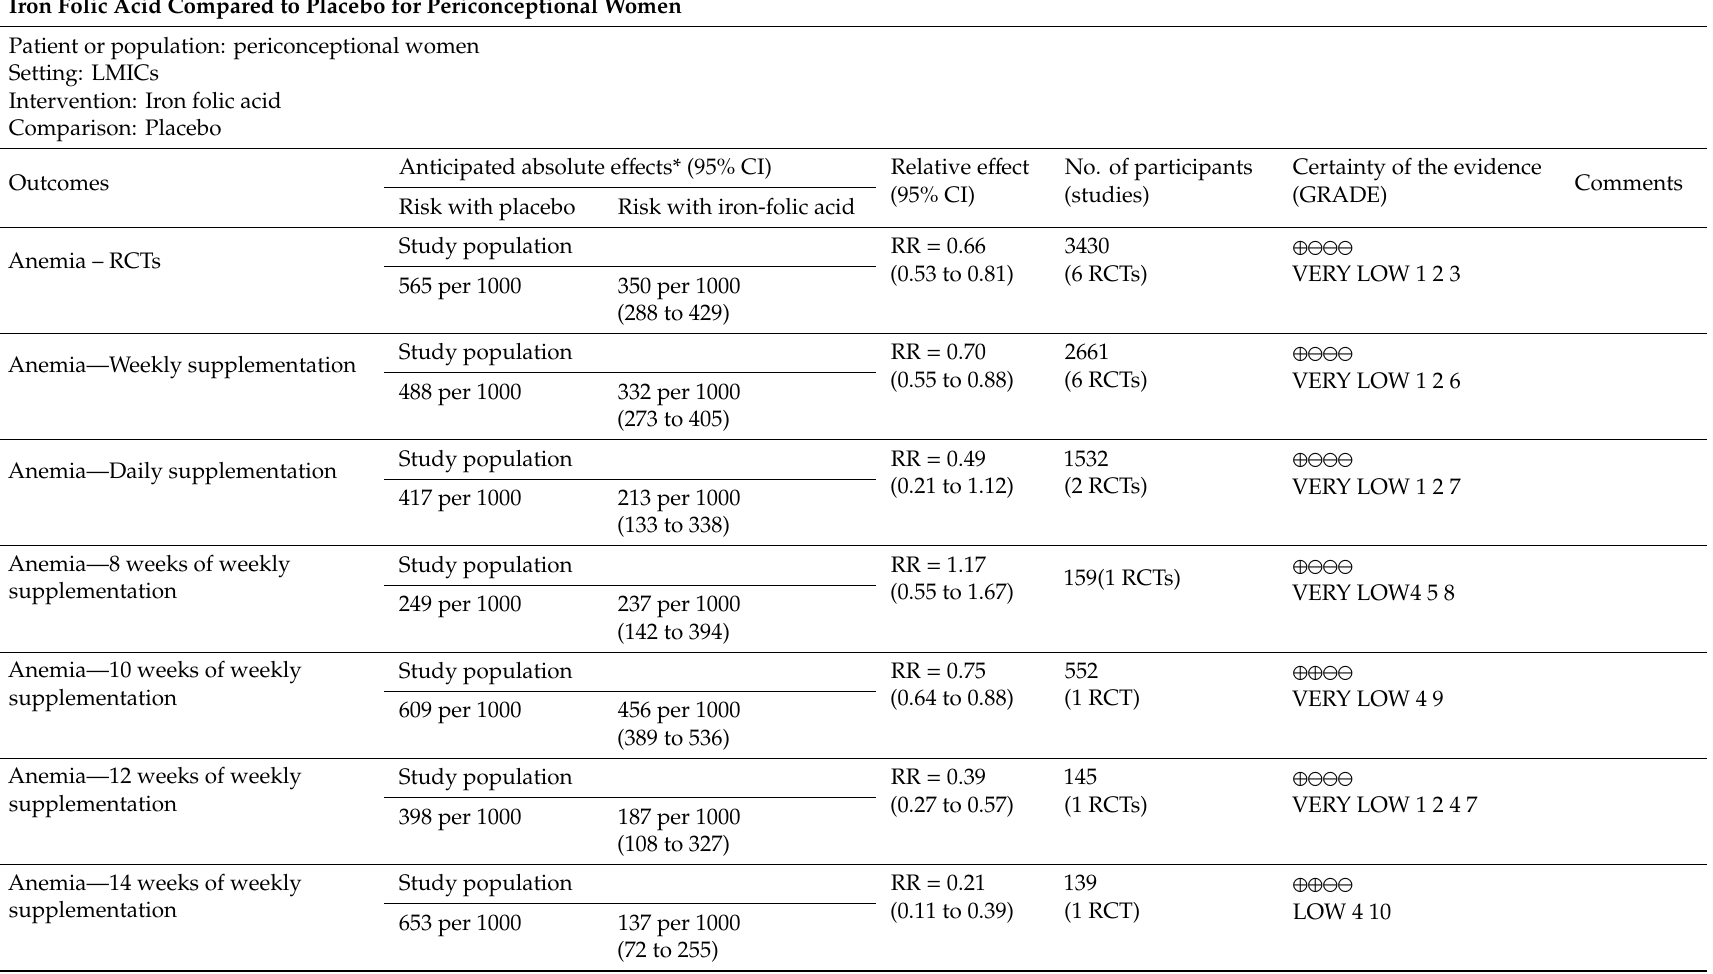
Table 5. Periconceptional iron folic acid supplementation compared to